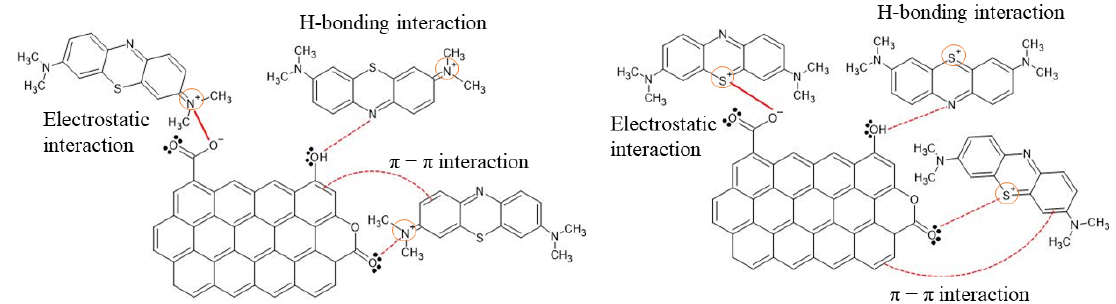
Figure 6. Scheme of the adsorption interactions of MB on biochar materials.